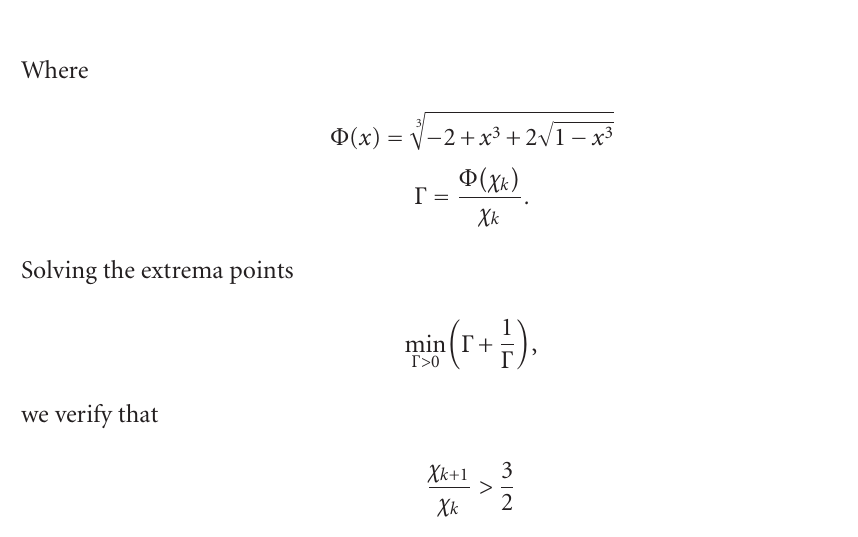
Figure 5.1. The Julia set in R